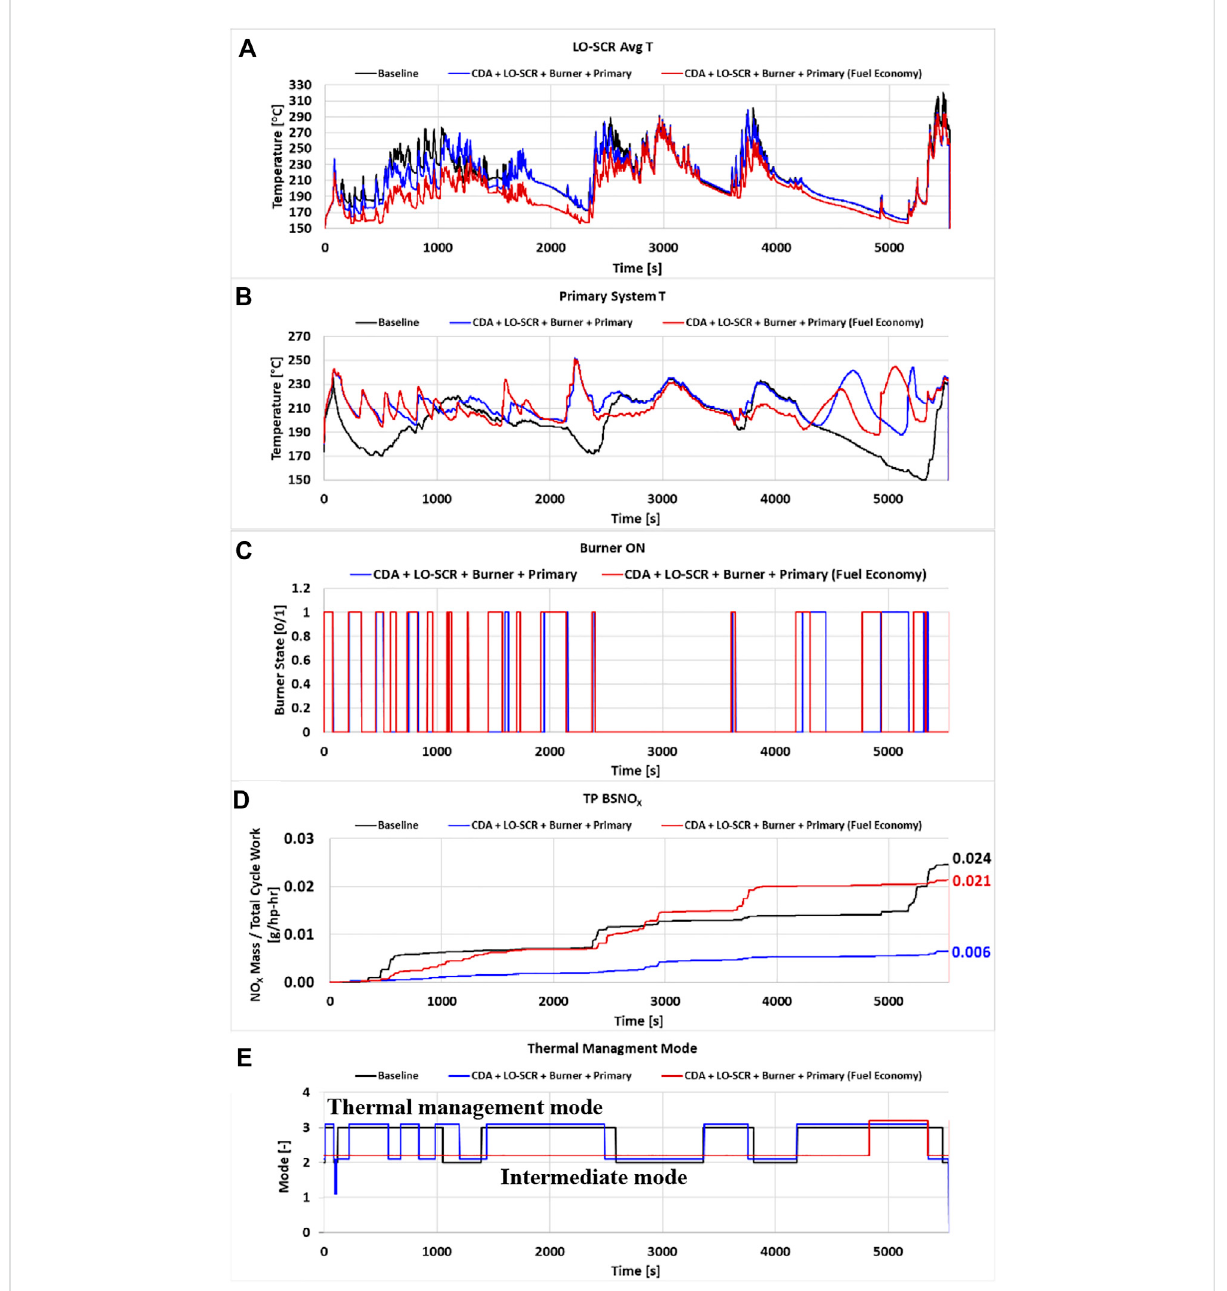
FIGURE 10 LLC measurement comparisons between Baseline and CDA + LO-SCR + Burner + Primary systems. The comparison includes an additional point with a fuel economy engine calibration. (A) LO-SCR temperature, (B) Primary system temperature, (C) Burner state, (D) Cumulative TP BSNO X , (E) Engine mode